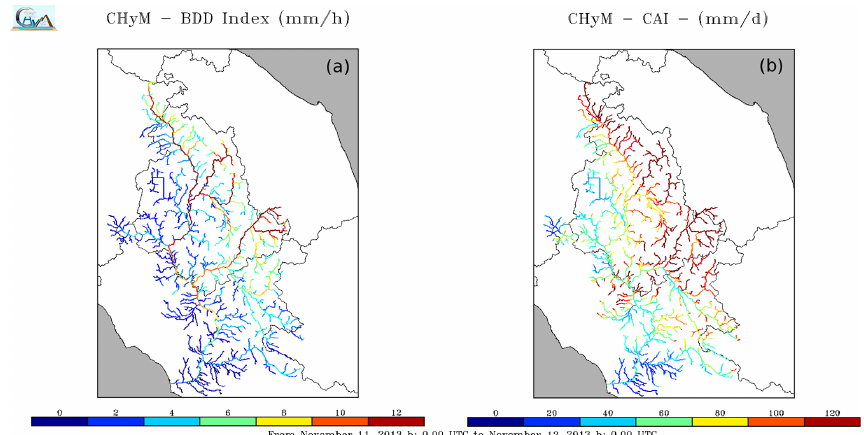
Figure 8. CS01 24h maps of the BDD index (a) and the CAI (b) obtained for 11 November 2013, by forcing CHyM with observed rainfall data. Warmer colours indicate river segments with higher flood stress. In both figures, the Umbria region drainage network, as well as the whole Tiber basin, is highlighted.